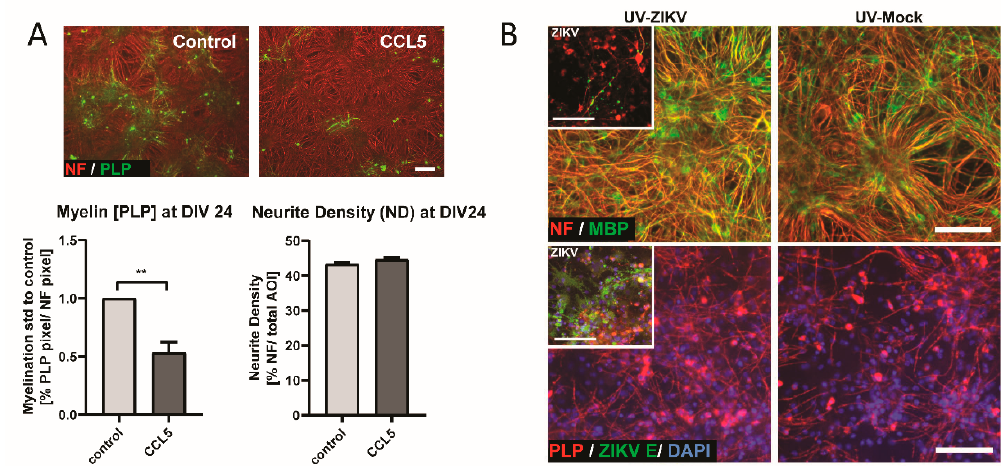
Figure 9. Effect of human CCL5 and UV treatment in CNS cultures. ( A ) CCL5 treatment (100 ng/mL) of rat CNS cultures from DIV 16 until DIV 24. Representative images of a control culture and a human CCL5 treated culture at DIV 24 are shown. Myelin and axons are shown by the immunofluorescence labeling of PLP (green signal) and NF (red signal). Graphs show the quantification of myelin and axons on DIV 24 per field of view of a captured image by CellProfiler software. Values for CCL5-treated cultures were normalized to control. Scale bar = 100 µ m; n = 7; Mean ± SEM; paired t -test; ** p < 0.01. ( B ) Supernatant of mock- or ZIKV-infected immature mouse CNS cultures was collected at 6 dpi and UV-treated to inactivate viral particles. UV-treated supernatant was mixed 3:1 with fresh medium. Analysis by IF at 6 dpt onto immature cultures. Representative images of myelin staining (MBP, green signal; PLP, red signal) and axon (NF, red signal) staining at 6 dpt (DIV 24) are shown ( n = 2). Inset images (upper panels) depict ZIKV (ZIKV E, green signal) infected CNS cells and pathology in cultures used for supernatant collection (6 dpi, DIV 24), with myelin (MBP, green signal; PLP, red signal) and neurofilament (NF, red) shown. Scale bar = 100 µ